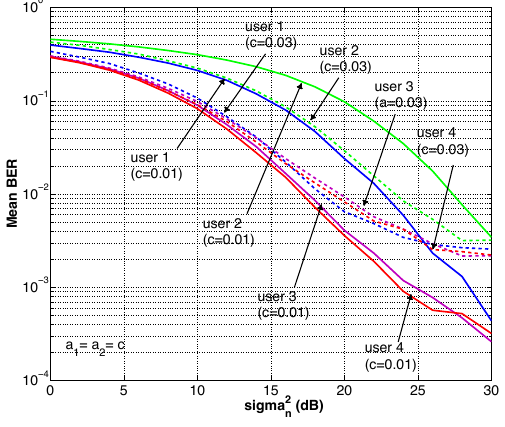
Figure 3. BER Performance of every user in the network (MIMO BC) for 𝑐 = 0 . 01 , 0 . 03 . For 𝑐 = 0 . 03 BER of each users tends to be the same for high SNR values.